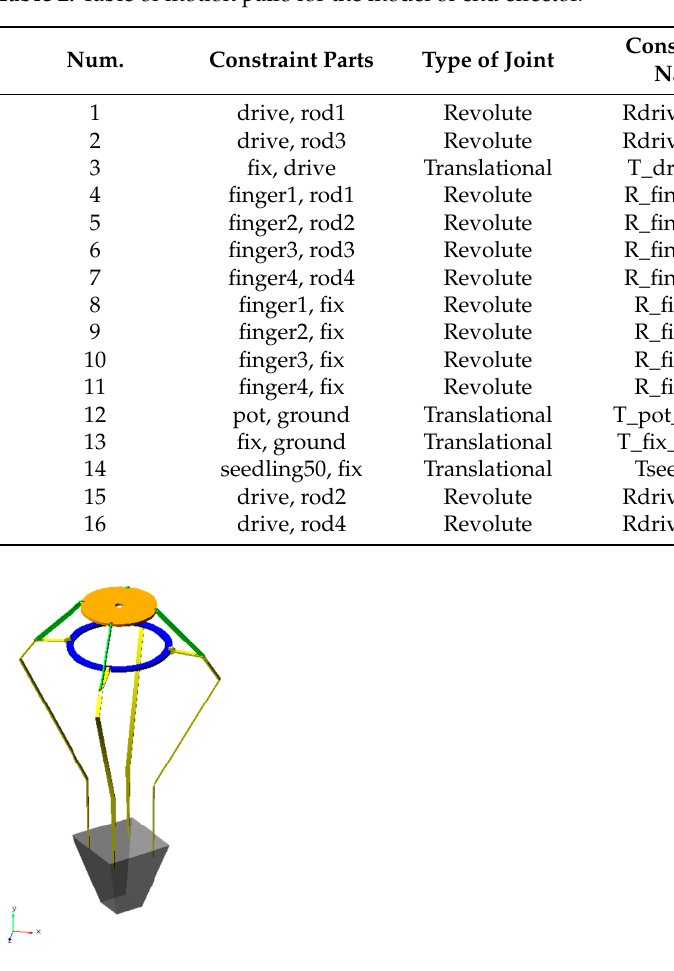
Figure 9. Virtual prototype model of seedling pick-up mechanism.